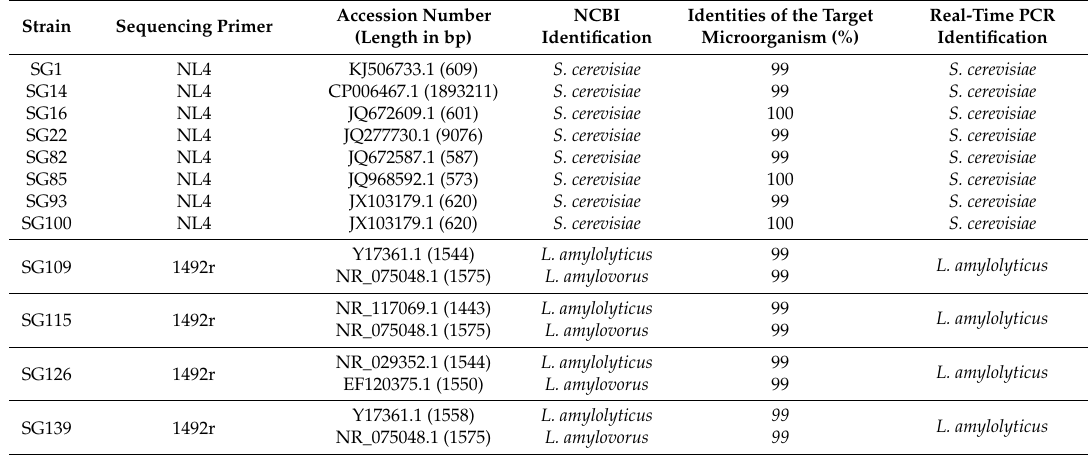
Table 2. Overview of the identified bacterial and yeast strains using the 16S and 26S rDNA gene sequencing,